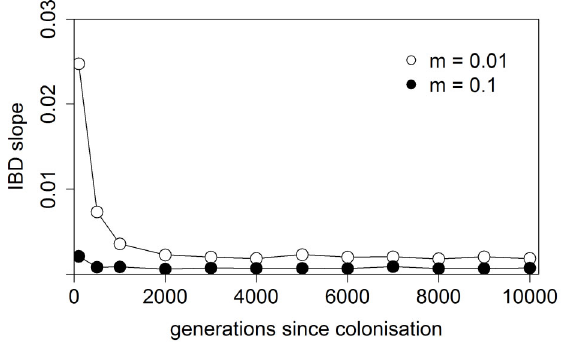
Figure 5. Changes in the slope of the isolation-by-distance relationship following a linear stepping-stone colonization process. Data were simulated in the program QuantiNemo (Neuensch- wander et al. , 2008) for 50 demes where, initially, only one edge deme was occupied. Colonization and migration took place only between neighbouring demes at a rate m (colonization rate and migration